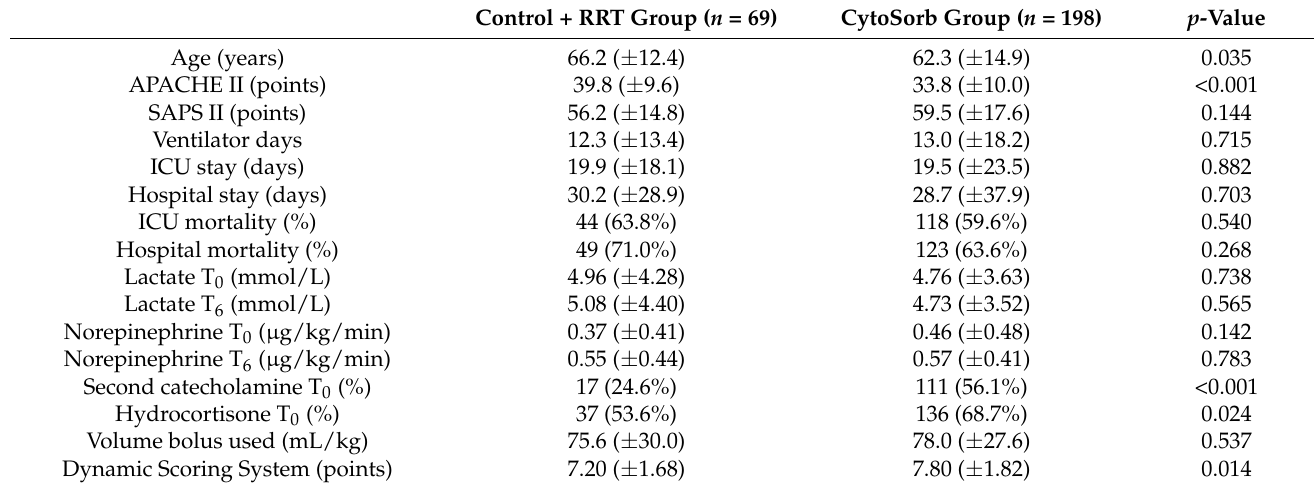
Table 5. Baseline characteristics, DSS relevant parameters and outcome variables in control + RRT patients and CytoSorb-treated individuals. Presented are mean values ± standard deviations, frequency and percentage (%) and levels of significance.